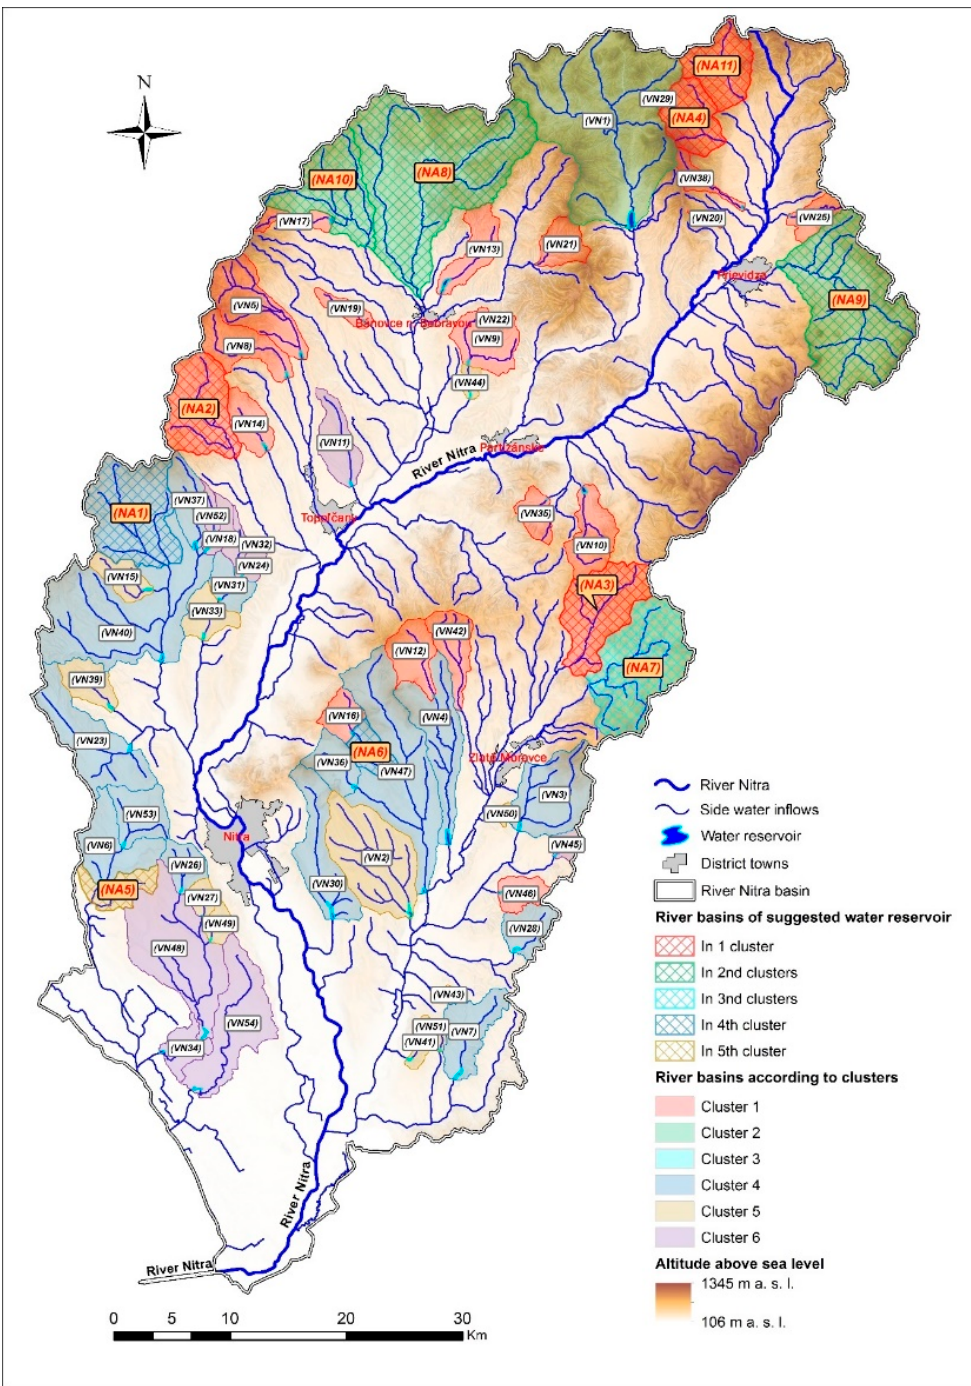
Figure 8. Map projection of the details of individual clusters.